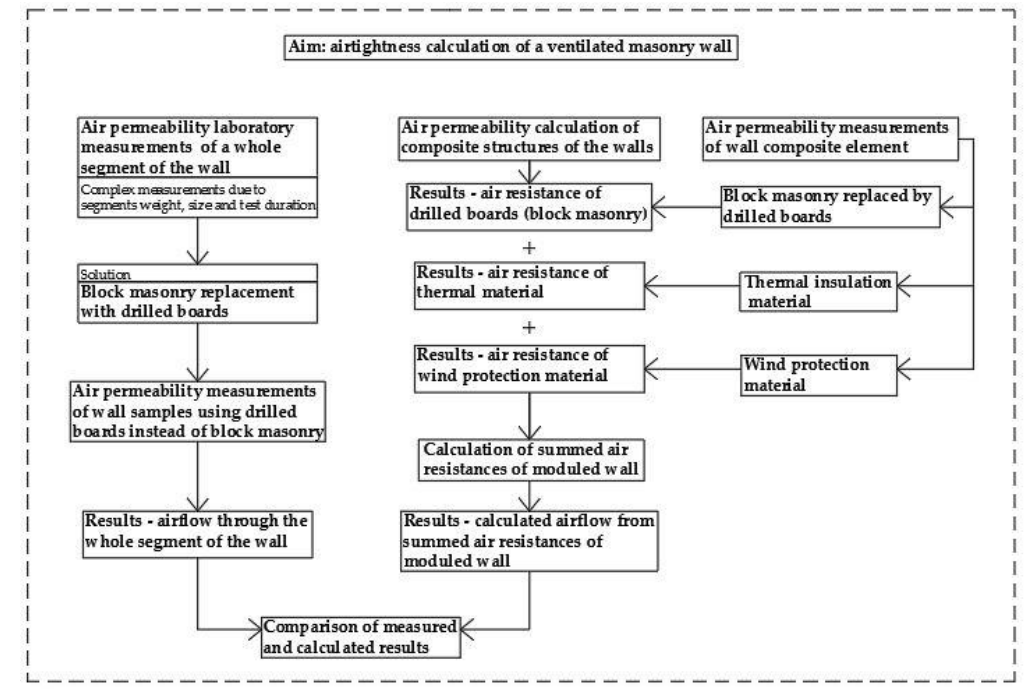
Figure 1. Layout of sequential arrangement of performed research.